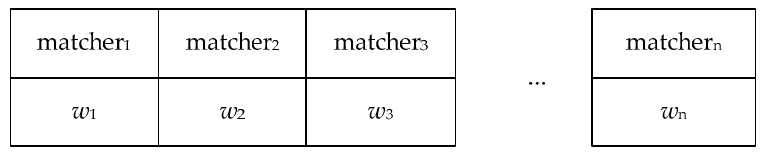
Figure 4. The chromosome for determining the weighted factors of string basic matchers.